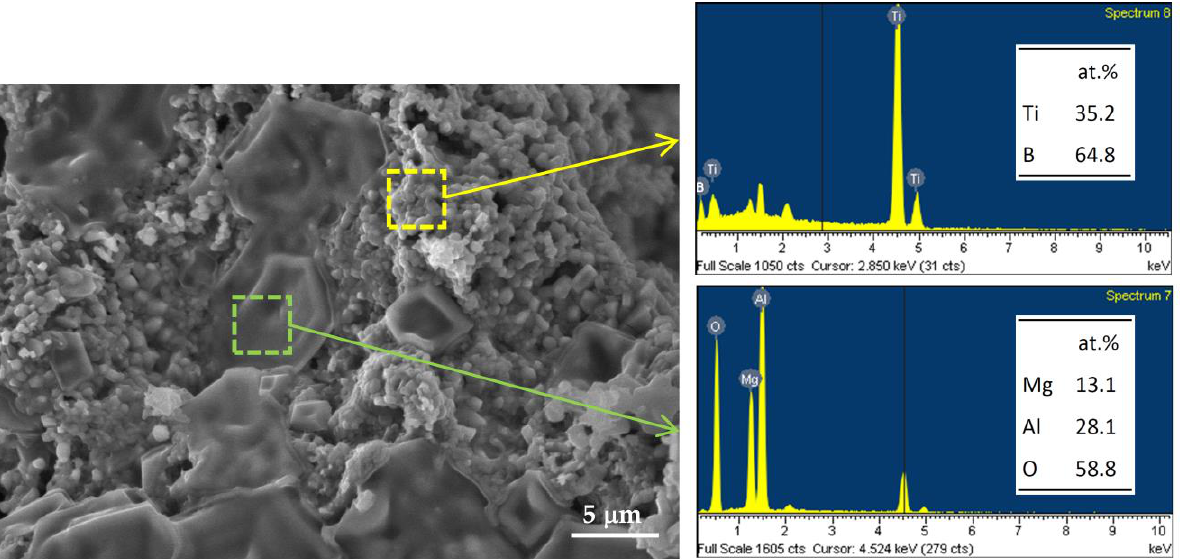
Figure 7. SEM image and EDS spectra of TiB 2 /MgAl 2 O 4 composite obtained from the SHS reaction of Equation